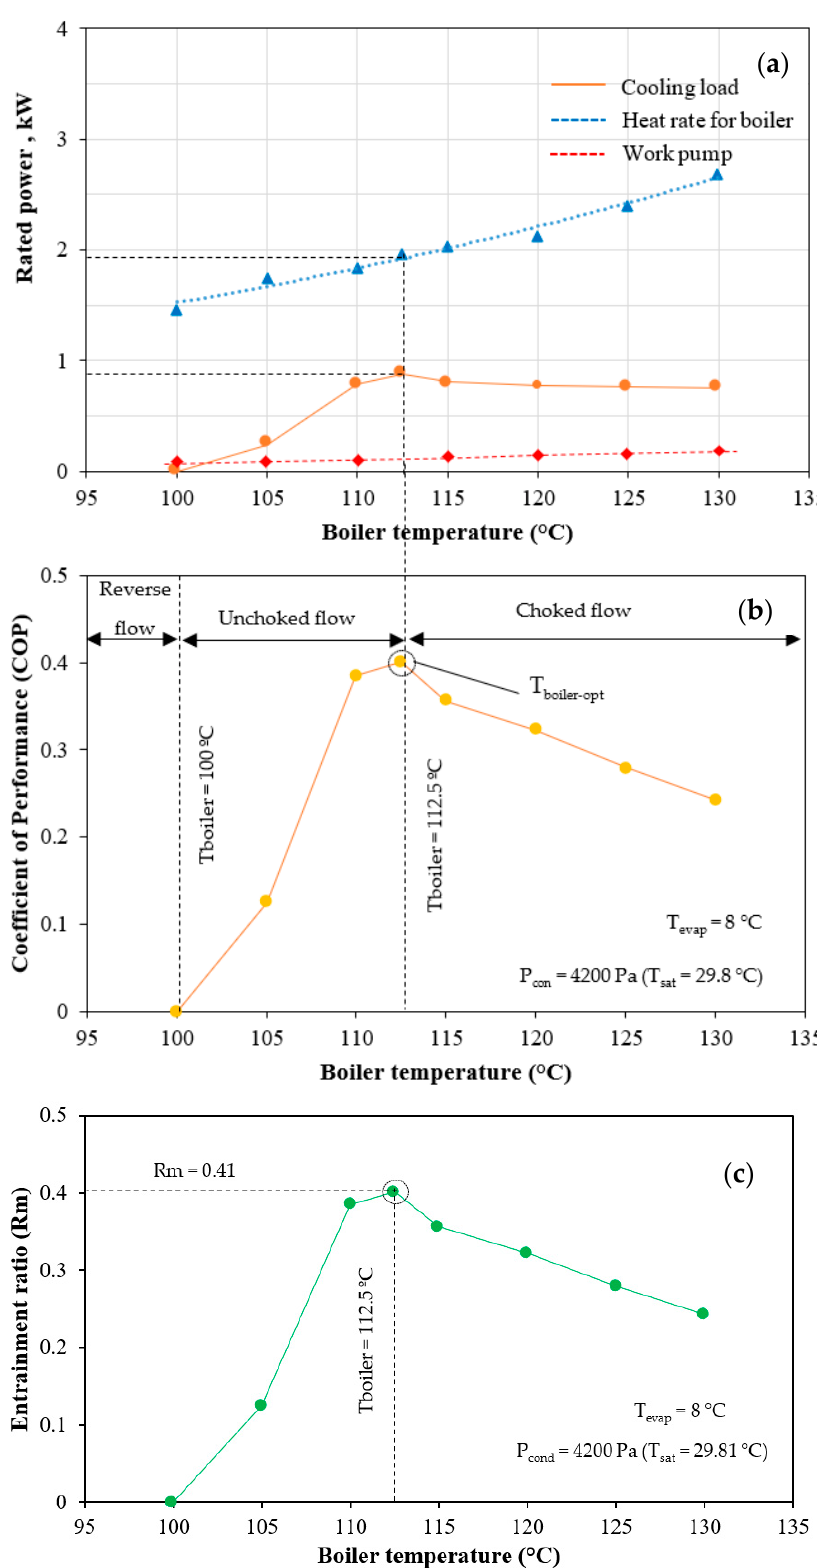
Figure 3. Parameters of interest influenced by the boiler temperature. ( a ) The rated power, thermal and electrical energy, with variations in the boiler temperature; ( b ) Variations in the COP with the boiler temperature; and ( c ) Variations in the entrainment ratio with the boiler temperature.